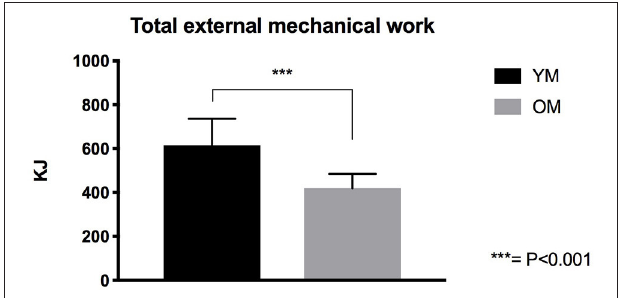
FIGURE 3 | Total External mechanical work performed by YM and OM